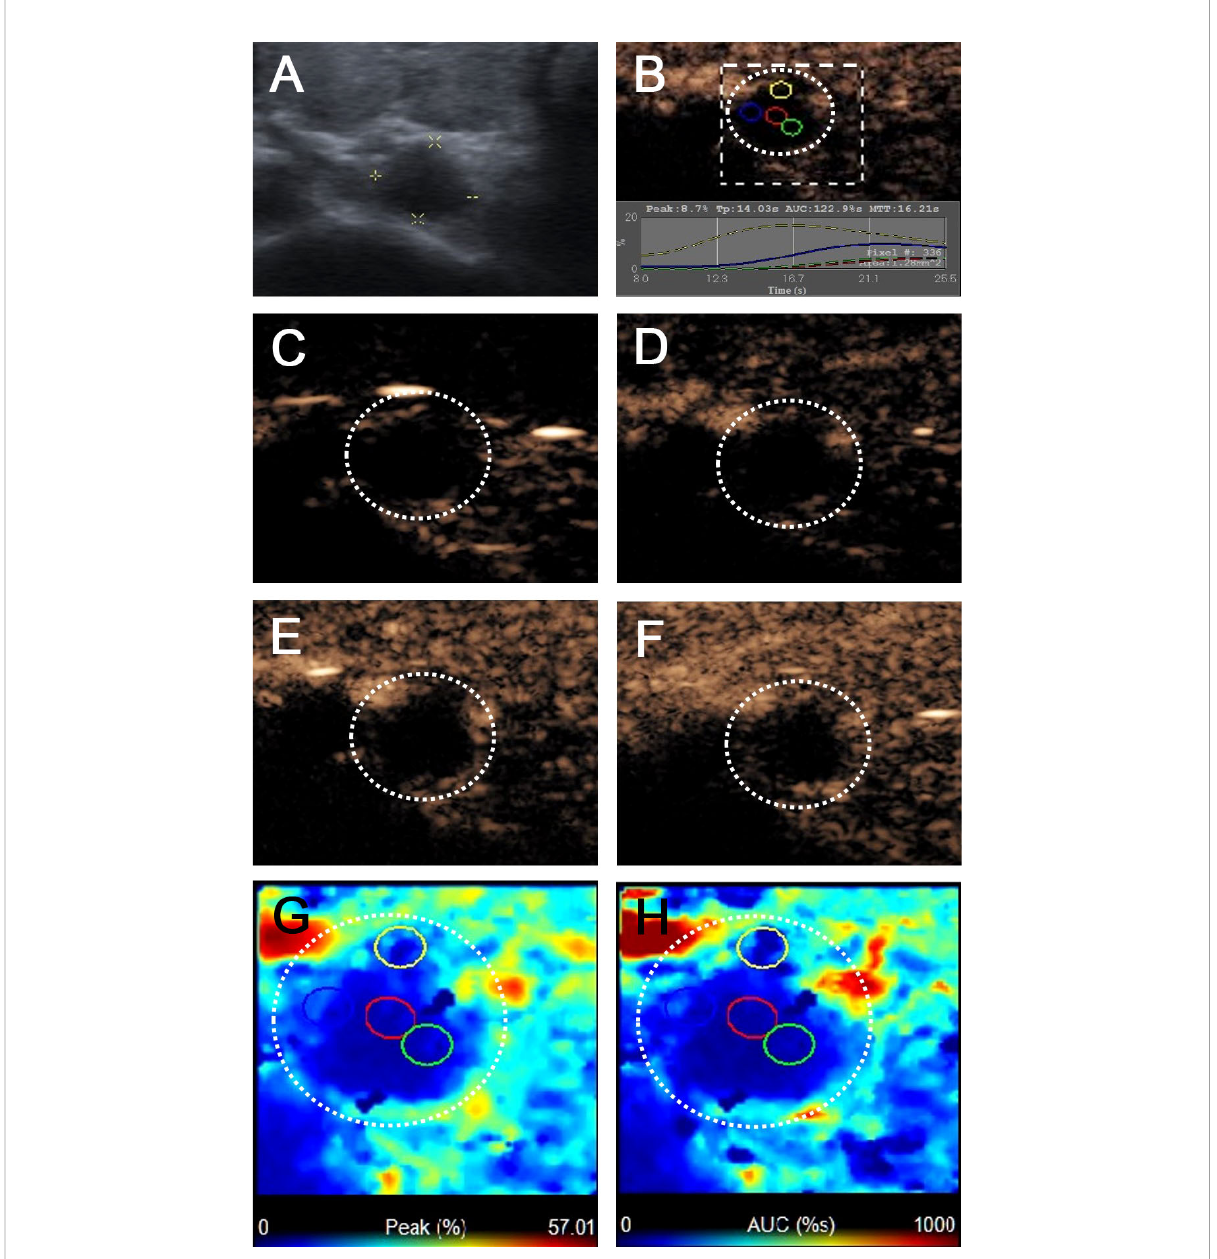
FIGURE 4 Metastatic lymph node in a 69-year-old female patient with PTC and Hashimoto ’ s thyroiditis. (A) The metastatic foci in a right paratracheal CCLN (white cross) identi fi ed on conventional US, showing L/S <2 and absence of fatty hilum appearance. (B) Time-intensity curve of CCLN. (C – F) CEUS images showed no microbubbles signal in the CCLN at different times (C) before injection of contrast agent, (D) 10 s, (E) 12 s, (F) 15 s after injection of contrast agent. (G, H) Parametric color maps of PI and AUC values, PI and AUC values of the whole lymph nodes (blue color) was lower than the surrounding tissue (cyan and red colors), means PI index ≤ 1 and AUC index ≤